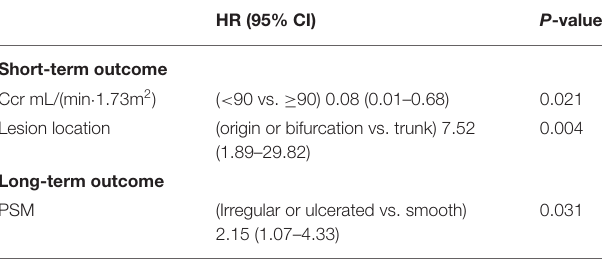
TABLE 1 | Significant factors for short or long-term outcome in Multivariable Cox regression analyses. HR (95% CI) P -value